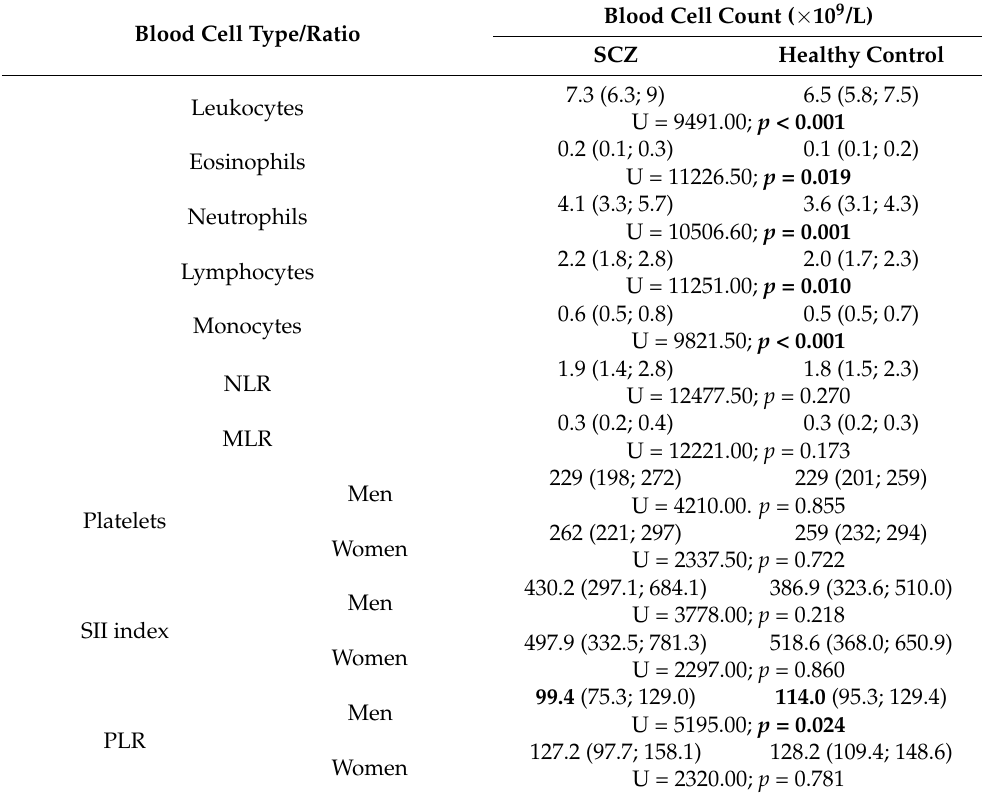
Table 3. Differences in blood cell counts and their ratios between patients with SCZ and healthy control subjects. Data are expressed as median (Q1;